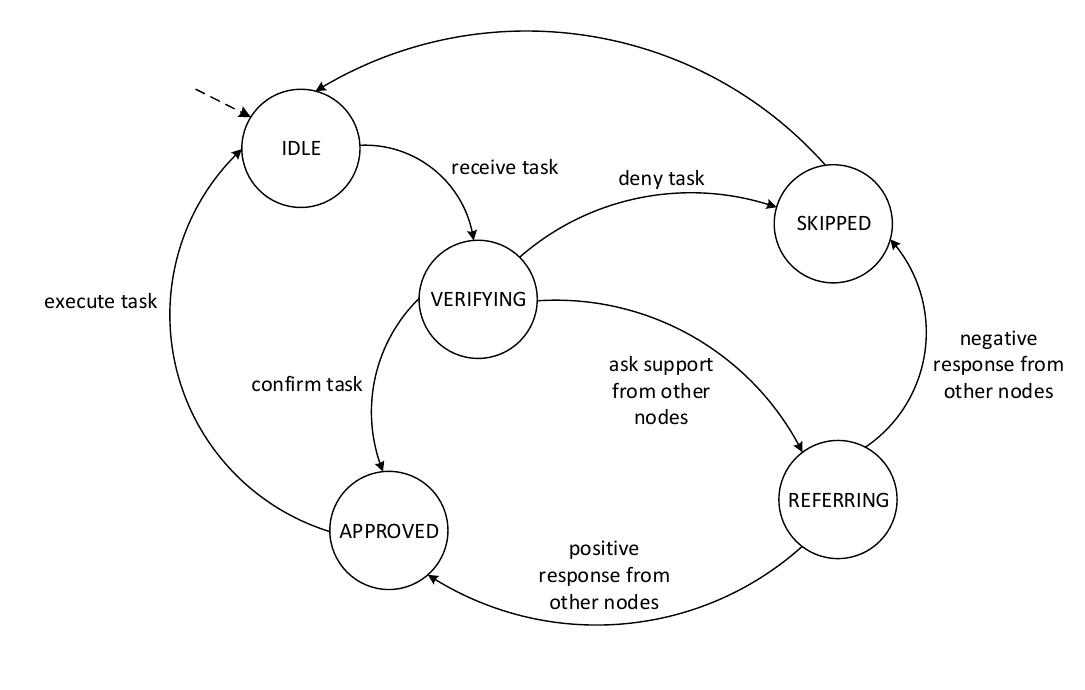
Figure 3. Validation